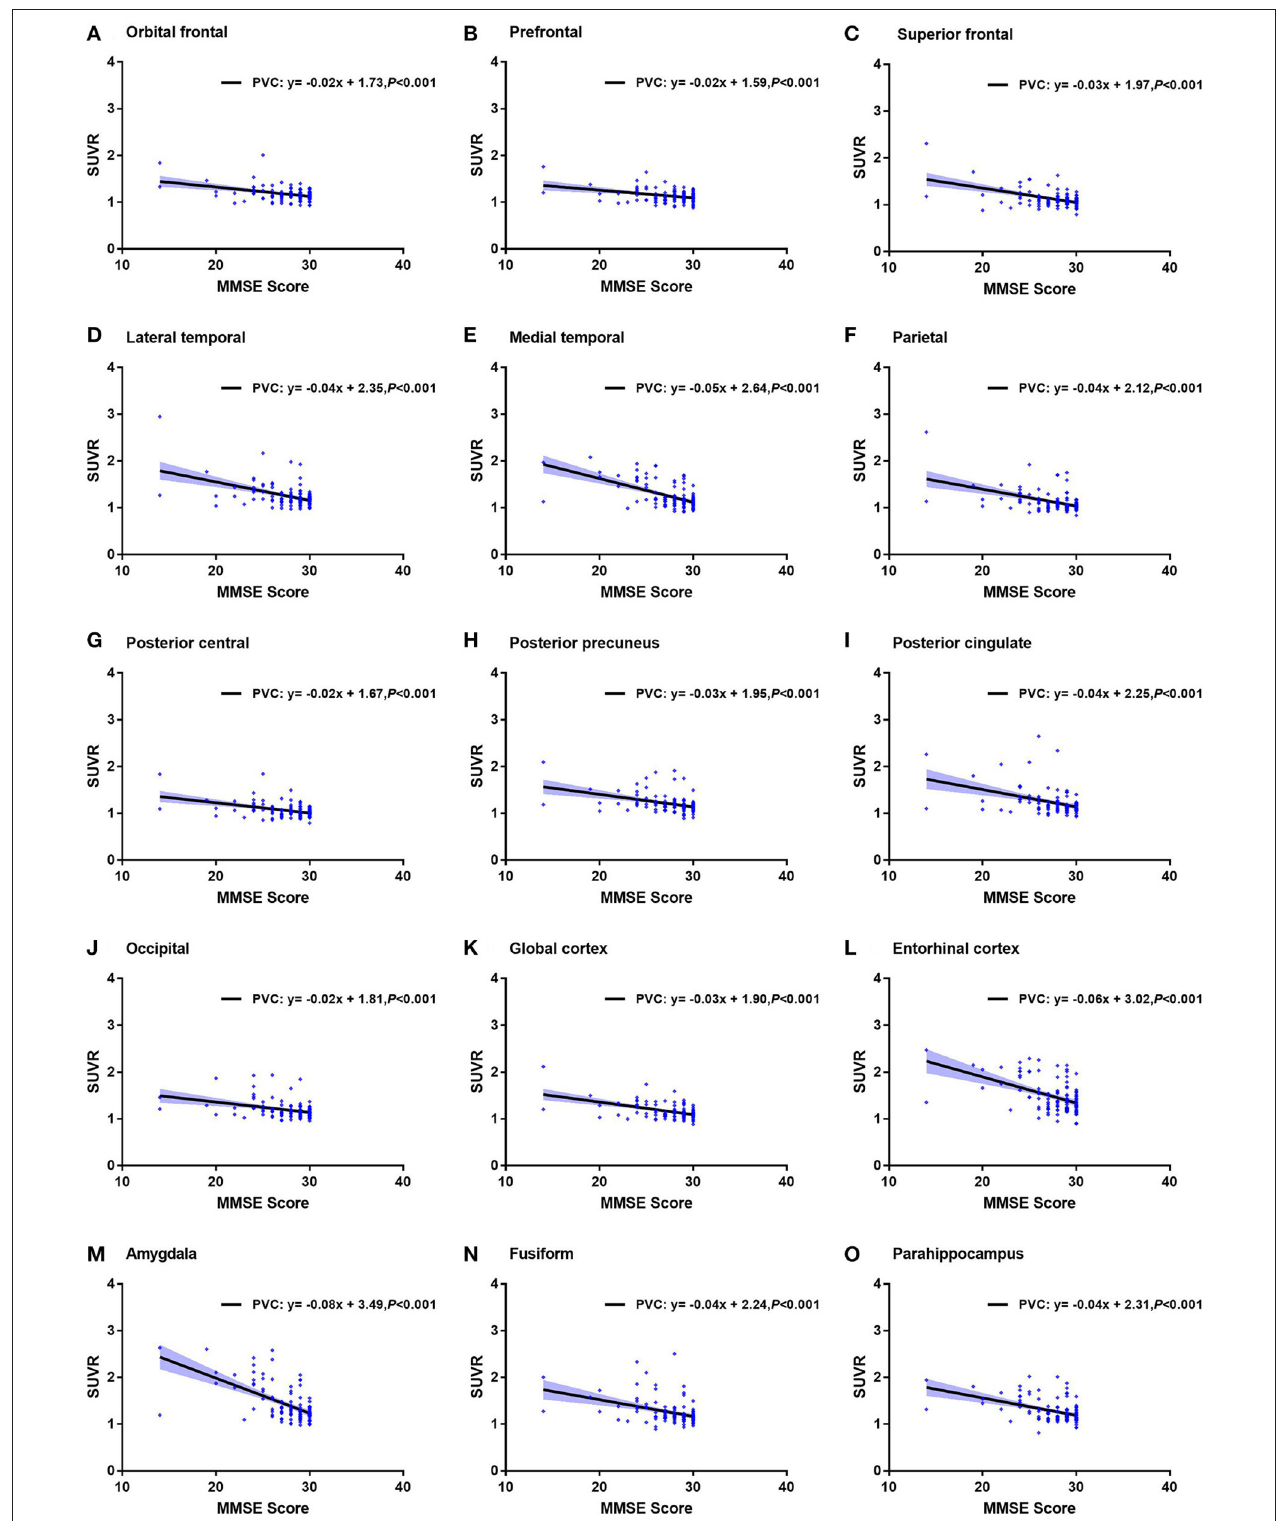
FIGURE 4 | Correlation of MMSE and 18 F-AV1451 deposition in ROI SUVRs with PVC. Correlation of MMSE and ROI SUVRs with PVC in the orbitofrontal cortex (A) , prefrontal cortex (B) , superior frontal cortex (C) , lateral temporal cortex (D) , medial temporal cortex (E) , parietal cortex (F) , posterior central cortex (G) , posterior precuneus (H) , posterior cingulate (I) , occipital cortex (J) , global cortex (K) , entorhinal cortex (L) , amygdala (M) , fusiform (N) and parahippocampus (O) .